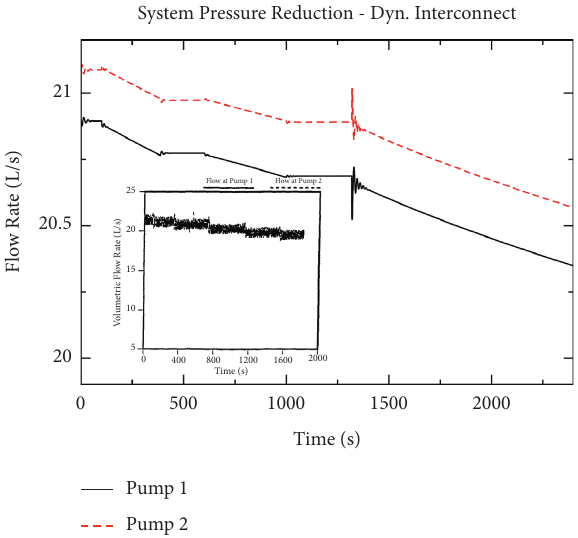
Figure 39: Flow oscillations resulting from system pressure reduction with dynamic similarity